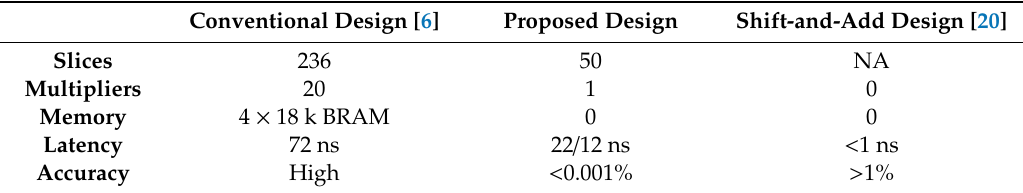
Table 5. Comparison of area, latency, and accuracy of a conversion from LNS to FLP.